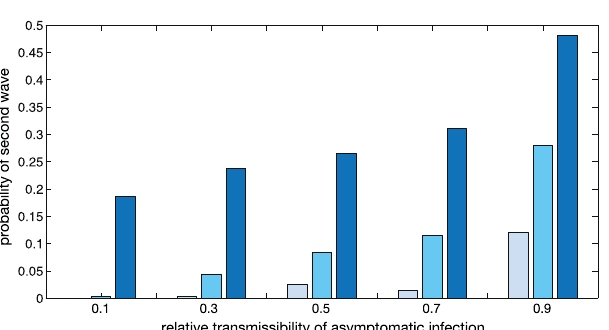
Figure 2. The probability of a second wave of ZIKV outbreak occurring as a function of the relative transmissibility of asymptomatic infection. Color bars correspond to scenarios in which infection transmission from symptomatic cases to mosquitoes was reduced by 10% (dark blue), 30% (light blue), and 50%